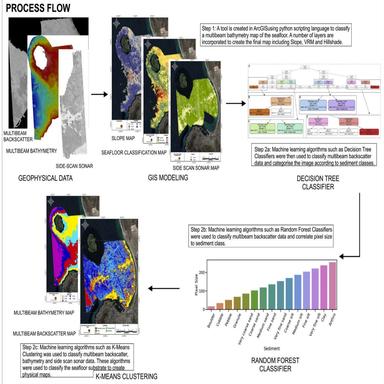
An overview of the methods described to classify the sidescan sonar, multibeam bathymetry and multibeam backscatter data is provided in the figure above. It highlights the processes described in the methods section to classify the data as well as the final maps or images created using each of the software programs.